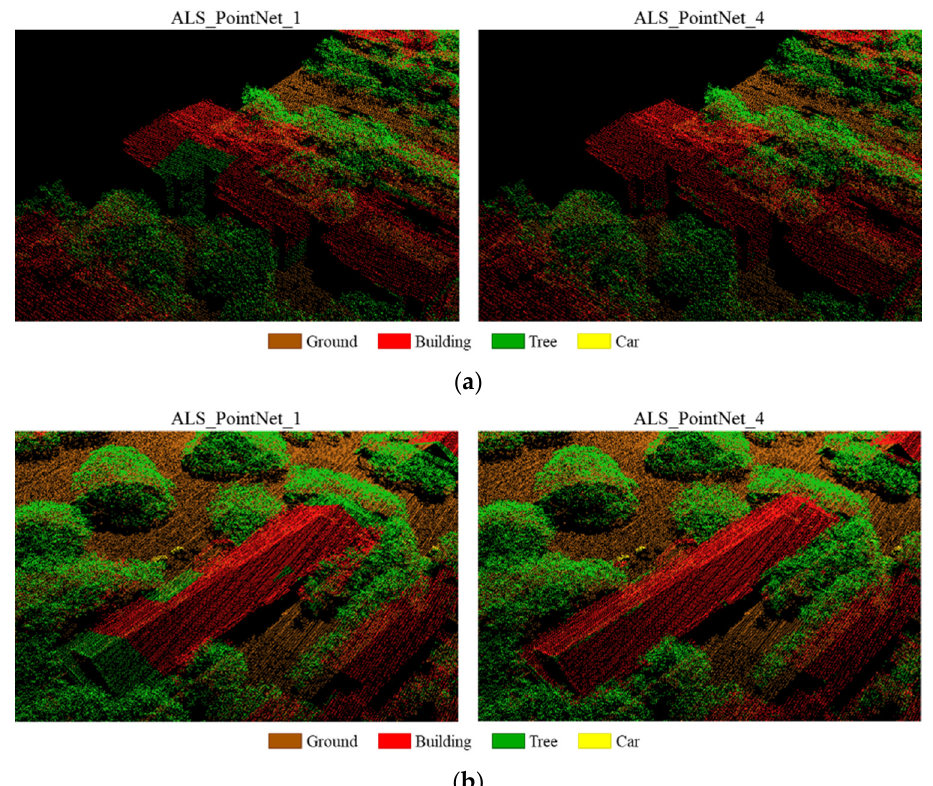
Figure 15. Classification efficacy of PointNet after the addition of features (left: ALS_PointNet_1; right: ALS_PointNet_4): ( a ) Lower degree of misclassification of the buildings as the trees; ( b ) Lower degree of misclassification at the junction of the edge of the buildings and the trees.